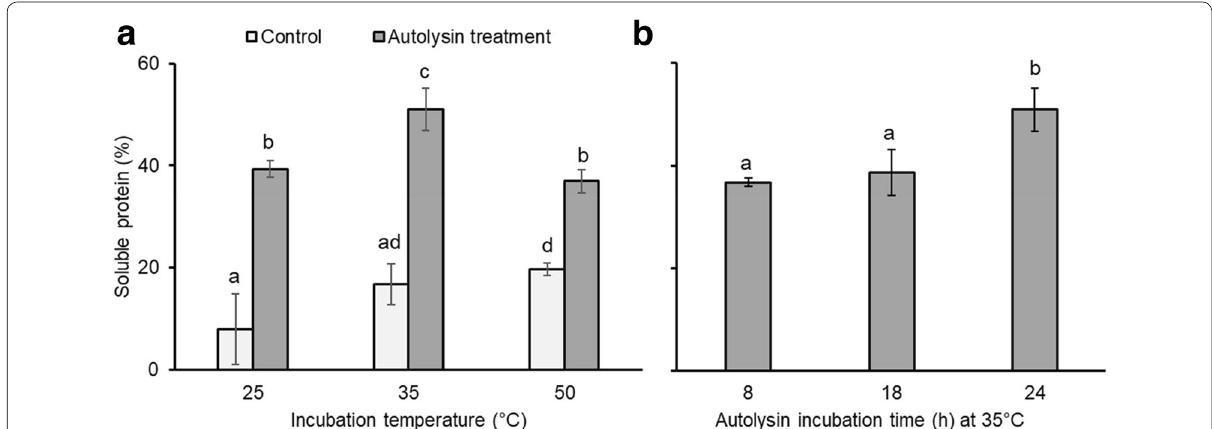
Fig. 2 a Percent of total soluble protein released after 24 h of autolysin treatment at 3 different incubation temperatures and b percent of protein released at 35°C at 3 different incubation times. Percentages were calculated based on a total extractable protein reference. Error bars represent standard error for n > 3. Comparisons were made within and between groups and significant differences were corrected for multiple comparisons 0.05. Different letters represent significant difference between with Tukey adjustment and an α FER =